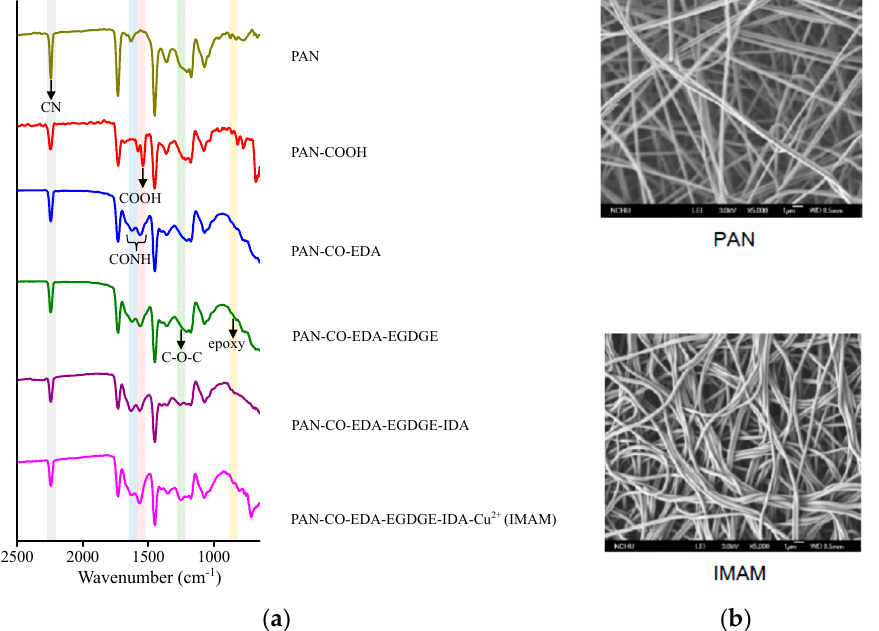
Figure 3. ( a ) ATR-FTIR spectra on various membrane modification steps in the process of IMAM preparation and ( b ) SEM images of the pristine PAN membrane and IMAM.